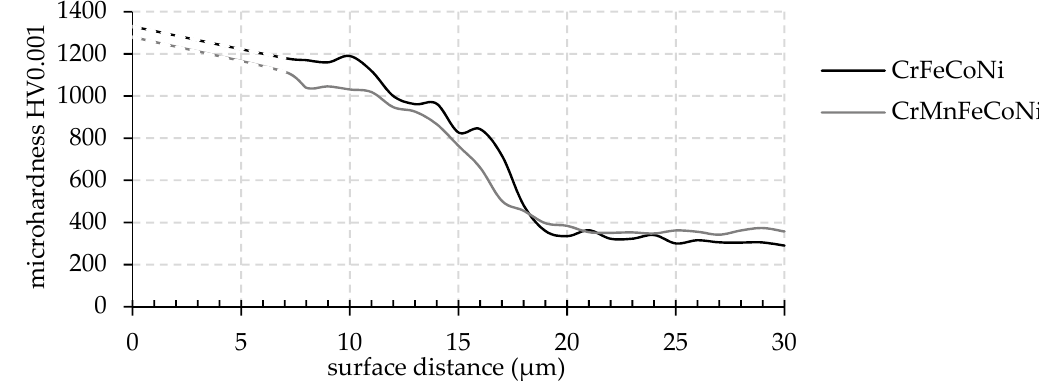
Figure 4. Microhardness of CrFeCoNi and CrMnFeCoNi in nitrocarburised state in dependence of the surface distance.